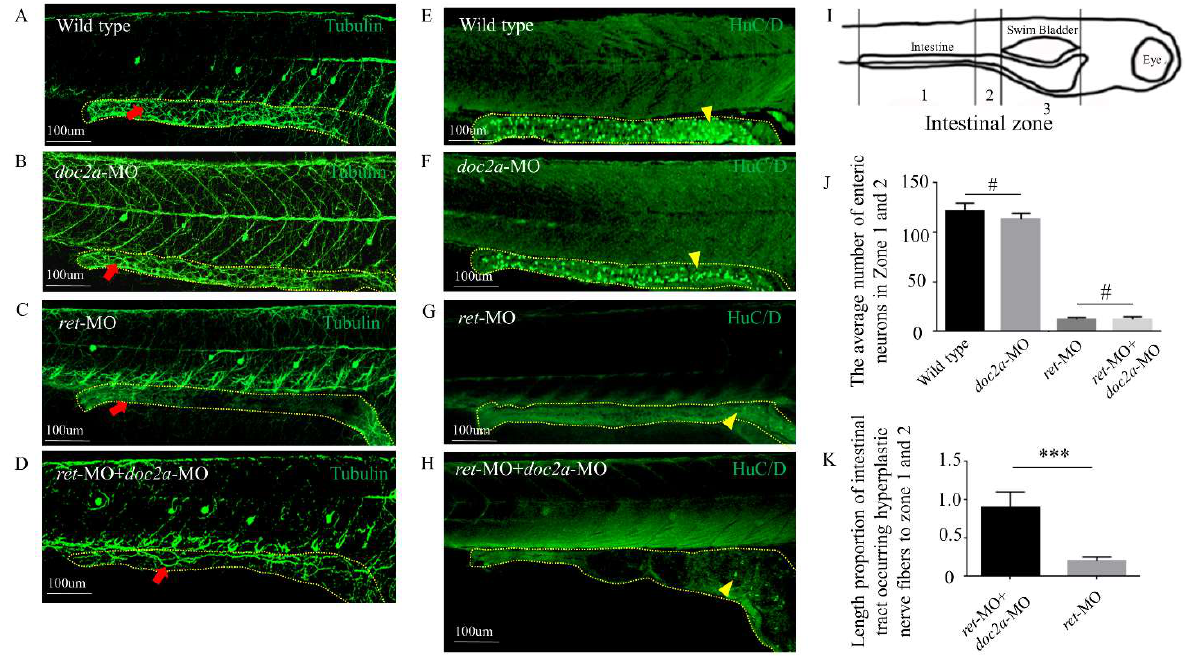
Figure 6. Investigation of Doc2a down-regulation promoting hyperplastic nerve fibers in zebrafish intestinal tract. ( A – D ) Comparison of enteric nerve fibers (Tubulin) in different groups. ( E – H ) Com- parison of enteric neurons (HuC/D) in different groups. Red arrow, enteric nerve fiber; yellow arrowhead, enteric neuron. ( I ) Diagram of zebrafish. ( J ) Comparison of average number of enteric neurons in zone 1 and 2. ( K ) Comparison of length proportion of intestinal tract with hyperplastic nerve fibers in zone 1 and 2. #, p > 0.05; ***, p < 0.001, one-way ANOVA with Bonferroni post hoc, n = 3. Abbreviations: MO, Morpholino; ret, ret proto-oncogene.